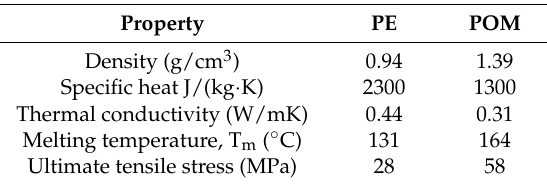
Table 3. Main properties of polymers.